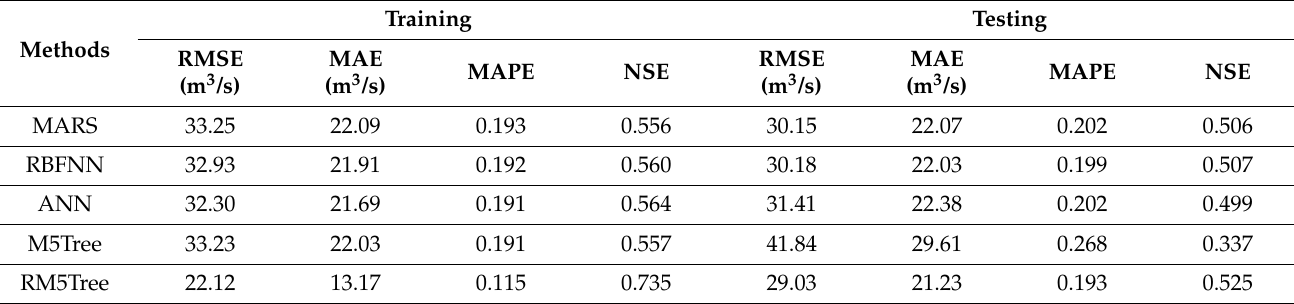
Table 7. Training and testing statistics of the RM5Tree, M5Tree, RBFNN, ANN, and MARS models in estimating daily streamflow prediction of Skallbole Station (downstream) using the optimal inputs